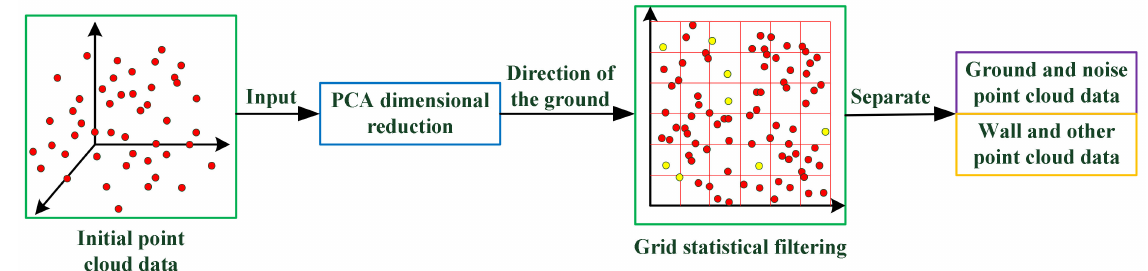
Figure 2. The filtering method based on grid principal component analysis (GPCA) is presented. The principal component analysis (PCA) algorithm is used to reduce the dimension of the initial data. A grid is constructed for the dimensionality reduction data. The number of points in the grid is counted. The data are divided into two parts by setting the threshold k σ